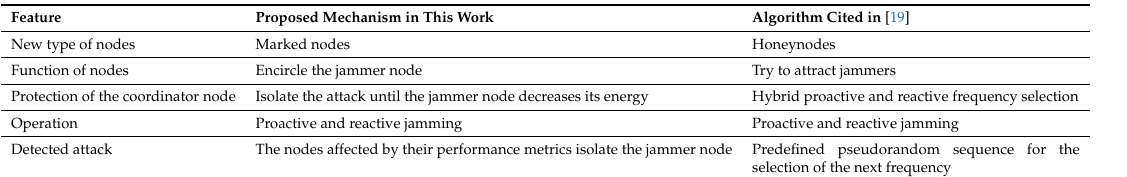
Table 7. Contributions of each algorithm.